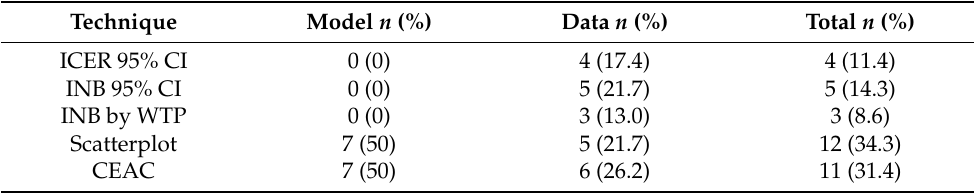
Table 3. Uncertainty technique by study design for 22 studies.